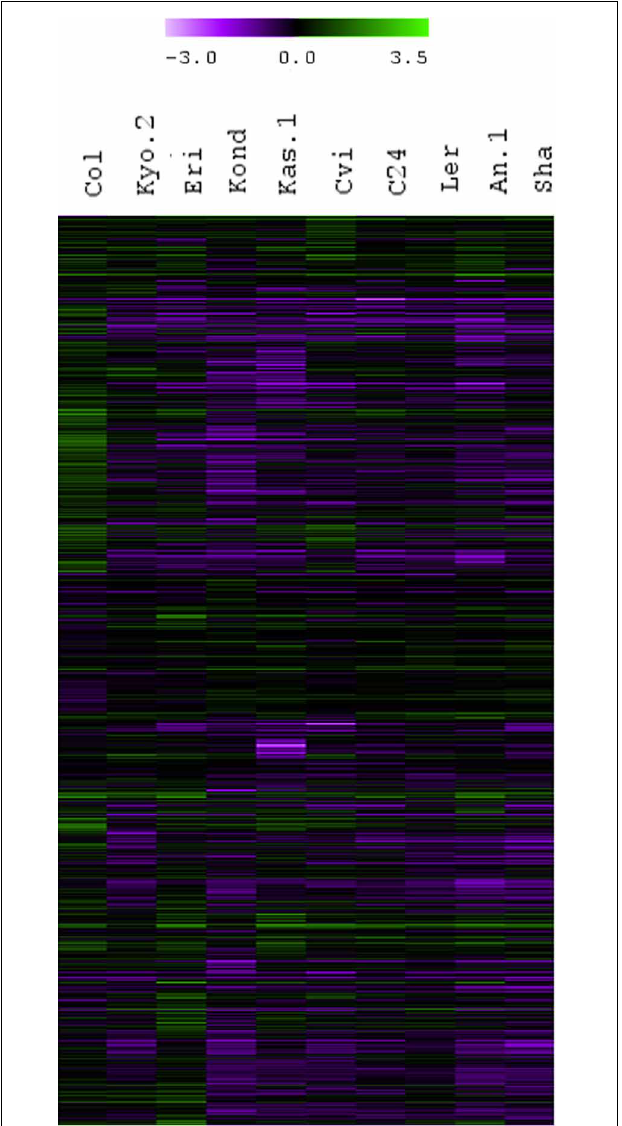
FIGURE 2 | Fold change values (treatment vs. control) calculated from normalized expression index for top 1000 significant genes from all the 10 ecotypes. Hierarchical clustering (HCL) was performed with Pearson correlation using average linkage method and 10,000 bootstrapping for the top 1000 heat regulated transcripts based on fold-change ratios compared to their respective controls.